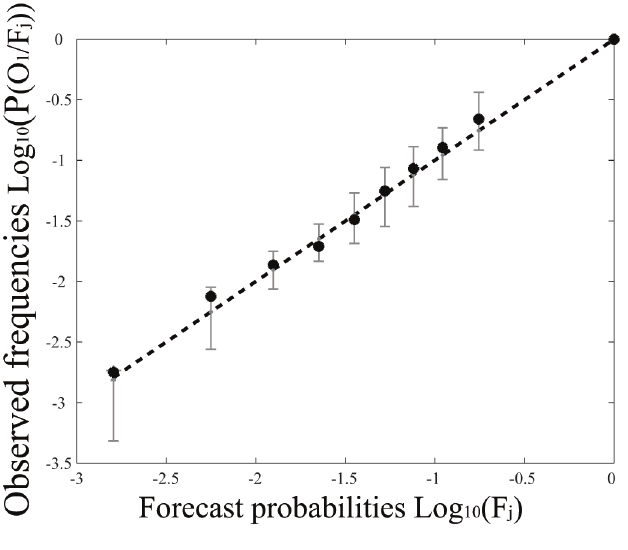
Figure 6. Cumulative reliability diagram of the spatial earthquake distribution predicted by the ETAS model for the testing INGV bulletin = 2.5; June 1, 2009 to September 1, 2009; 179 events). The stars mark the ( M c / p ( O | F ), i.e., the forecasts and the observed spatial distributions. pairs F j j 1 The dotted black line represents the perfect reliability. Error bars identify the 95% confidence intervals of the observed values p ( O identify equally populated bins B probabilities F j